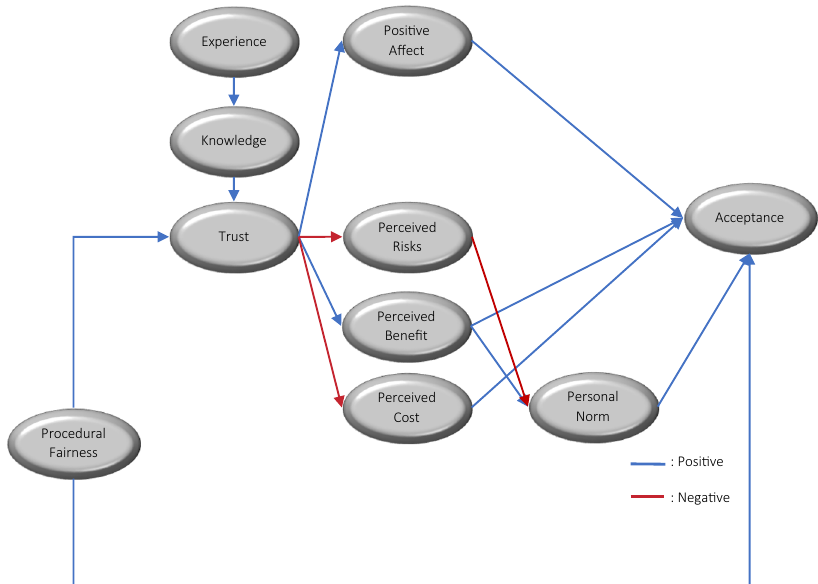
Fig. 5 Structural model results for the social acceptance of Forest Garden in Alcalá de Henares, Spain. Insigni fi cant variables are dropped from the theoretical model. Arrows represent the direction of causality between the latent variables. The red and blue arrows represent negative and positive associations,